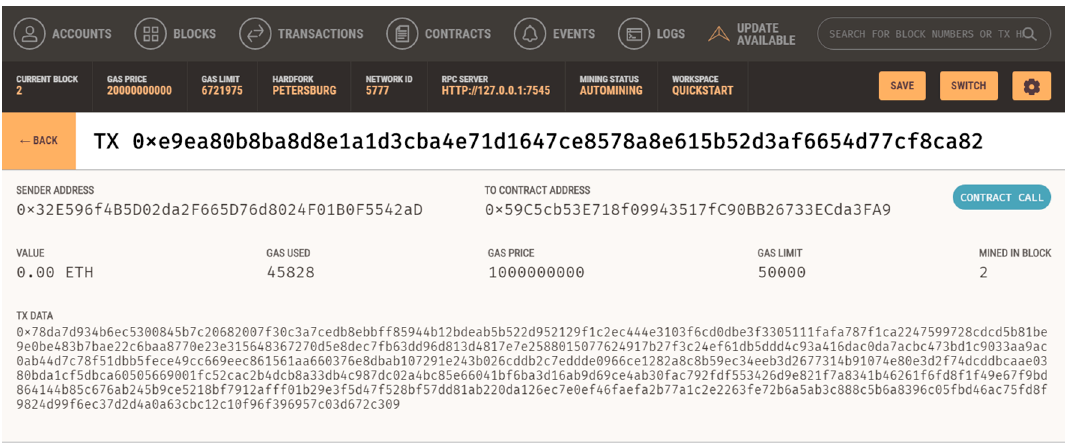
Figure 10. Compressed string transaction.